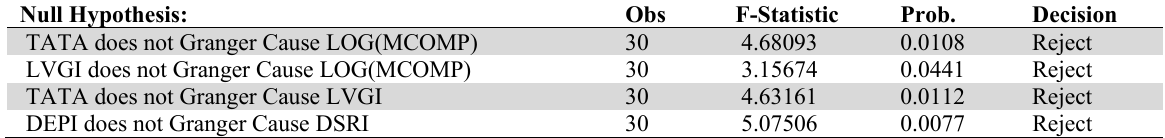
Granger Causality Test